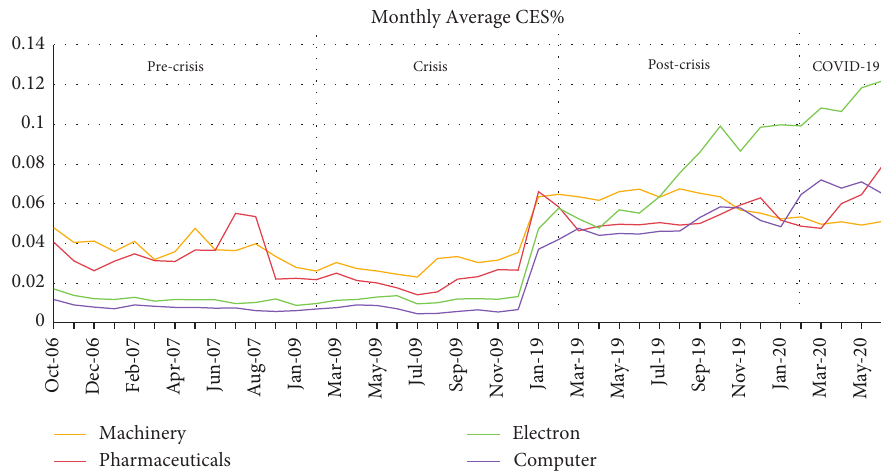
Figure 10: CES of the machinery, pharmaceuticals, electronics, and computer sectors in four periods